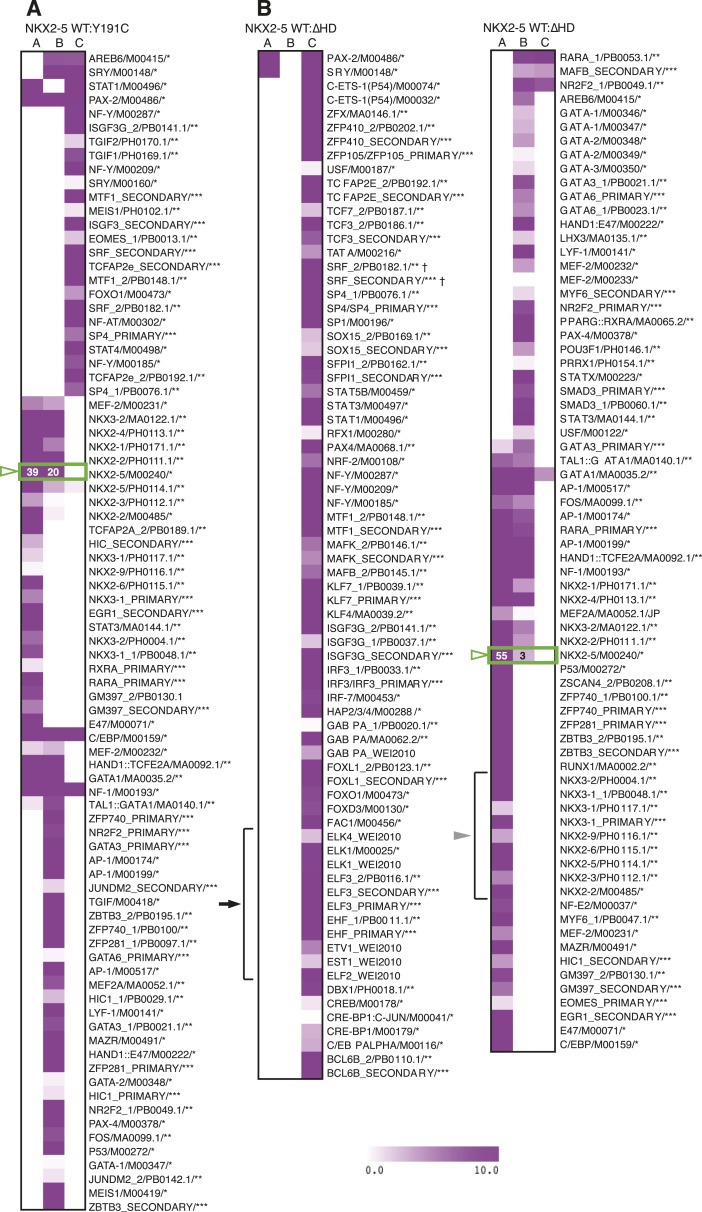
Enrichment of known motifs in NKX2-5 peak subsets.Heat maps showing motifs significantly enriched in subsets of the NKX2-5 WT/Y191C (A) or NKX2-5 WT/∆HD (B) comparisons. TF-binding sites from the TRANSFAC (*), JASPAR (**) and UniPROBE (Badis et al., 2009) (***) databases with a positive raw Clover score in ≥1 set are shown. The NKE is highlighted in a green box and ETS-like motifs are highlighted with black arrow. SRF† shows the secondary SRF motif, not the CArG box.